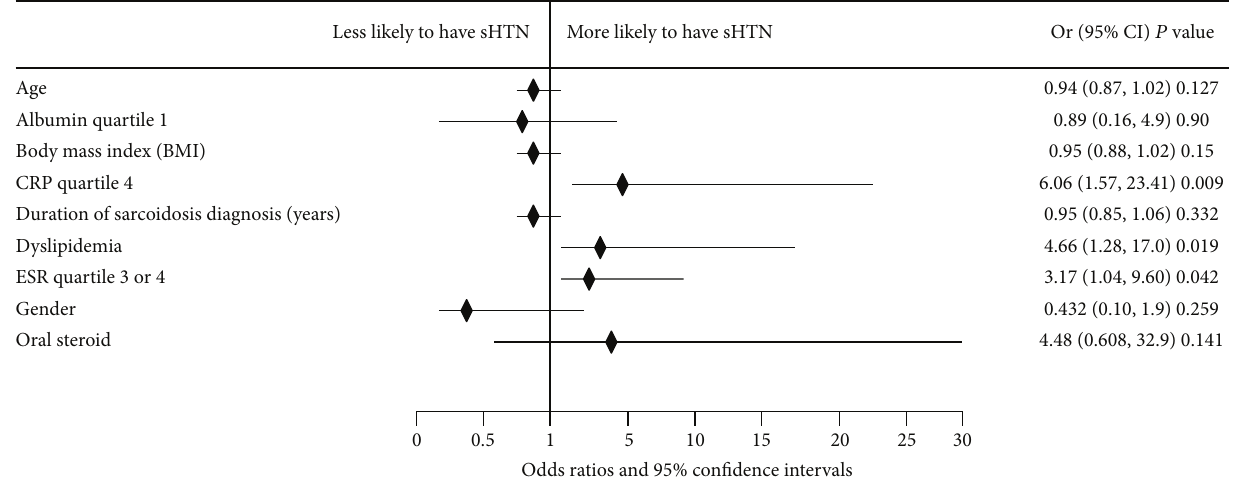
Figure 3: Forest plot of multivariate logistic regression analysis demonstrating independent factors associated with systemic hypertension in sarcoidosis patients. Hosmer and Lemeshow 𝑃 = 0.775